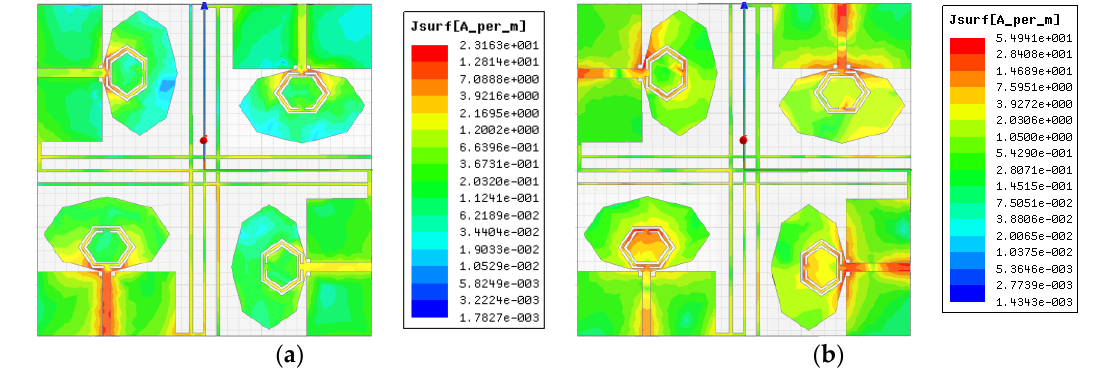
Figure 10. Current distributions at ( a ) 3.5 GHz; ( b ) 5.5 GHz.